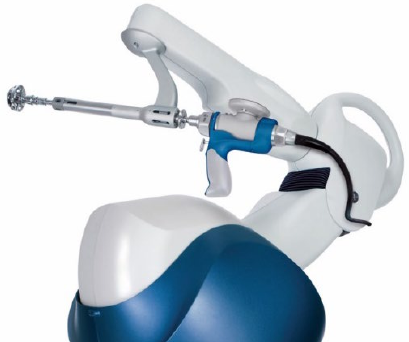
Figure 1. Stryker MAKO robot with acetabular reamer attachment.